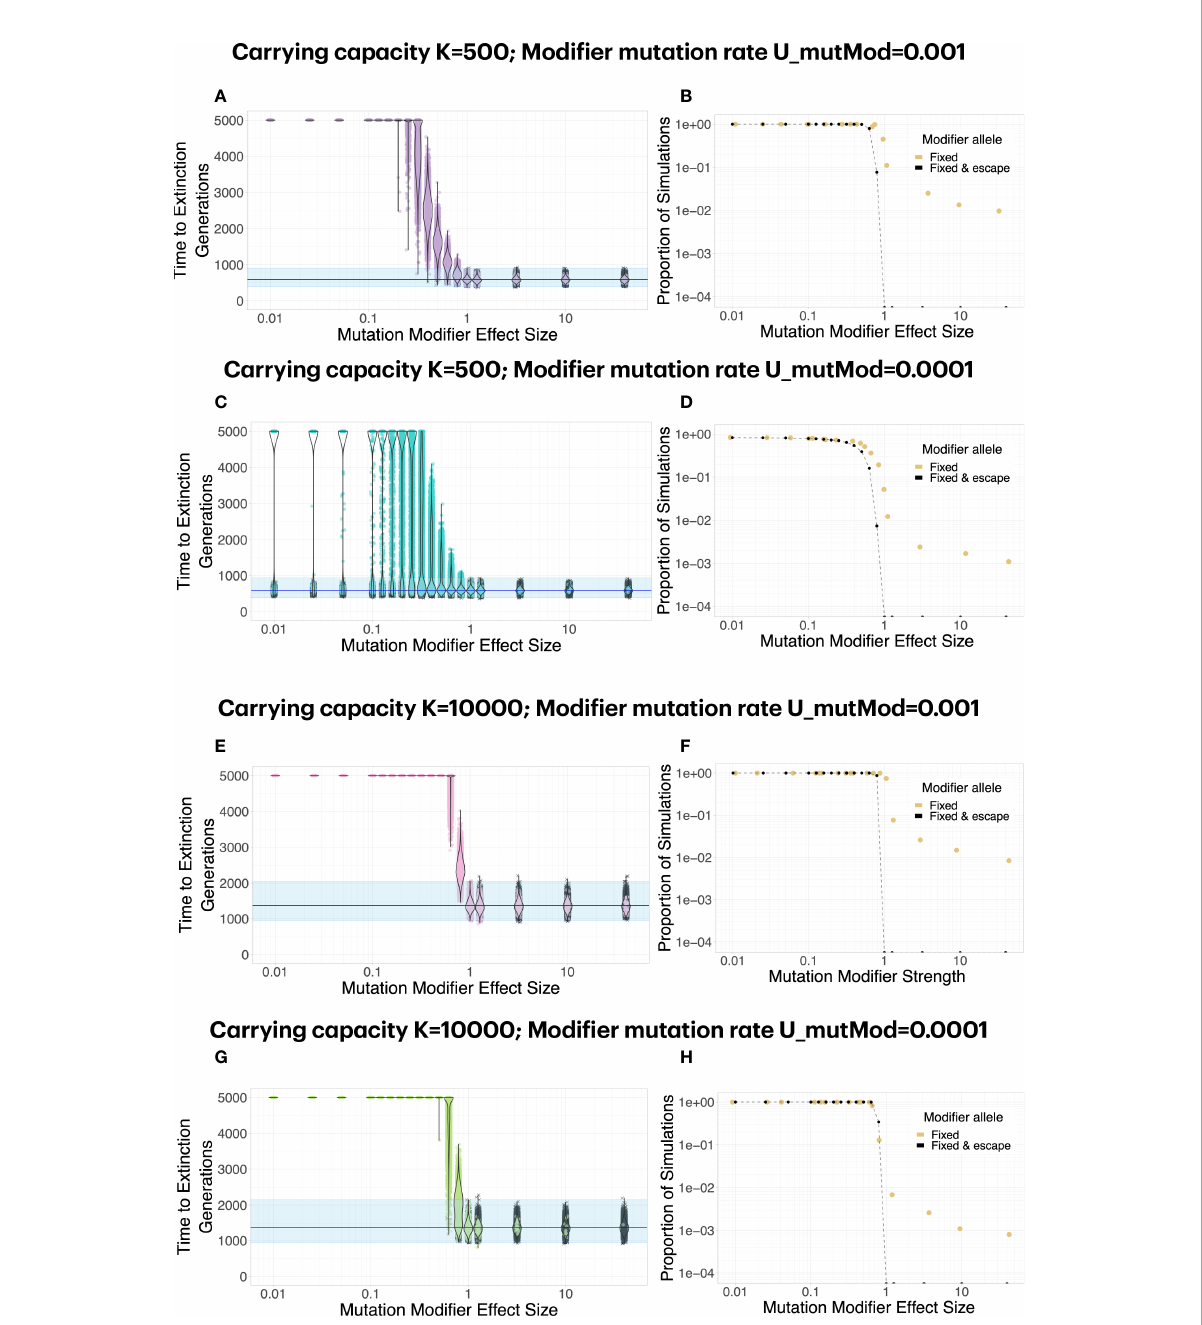
FIGURE 3 A mutation modi fi er of suf fi cient effect size can lead to escape from mutational meltdown. Each dot in (A, C, E, G) represents a simulation run; simulations in which the mutation modi fi er was fi xed in the population are shown in color, whereas simulations in which the modi fi er did not invade are shown in gray. Note that the effect size of the modi fi er, f mutMod , is de fi ned multiplicatevely: e.g., if f mutMod =0.1, the mutation rate is reduced to 10% of its original value. (B, D, F, H) . In general, a mutation modi fi er that suf fi ciently decreases the mutation rate is effective at fi xing in the population (yellow dots) and increasing the extinction time (black dots). Even when the modi fi er increases the mutation rate, it becomes fi xed in some simulations, caused by random drift during the extinction phase (yellow dots for f mutMod >1). The graph shows the proportion of simulations for which the modi fi er allele was fi xed (yellow dots), and the proportion of simulations for which it extended the extinction time beyond the maximum observed extinction time without the modi fi ers (black dots). (C) . For K=500, escape from mutational meltdown becomes more stochastic with a lower modi fi er mutation rate. With U mutMod =0.0001, even for very strong modi fi ers, there is a small probability that escape is unsuccessful when the modi fi er allele appears too late. (E – H) . At higher carrying capacities K=10000, escape from mutational meltdown is possible even with modi fi ers of relatively small effect, and the escape becomes more deterministic. Each parameter combination was simulated 10000